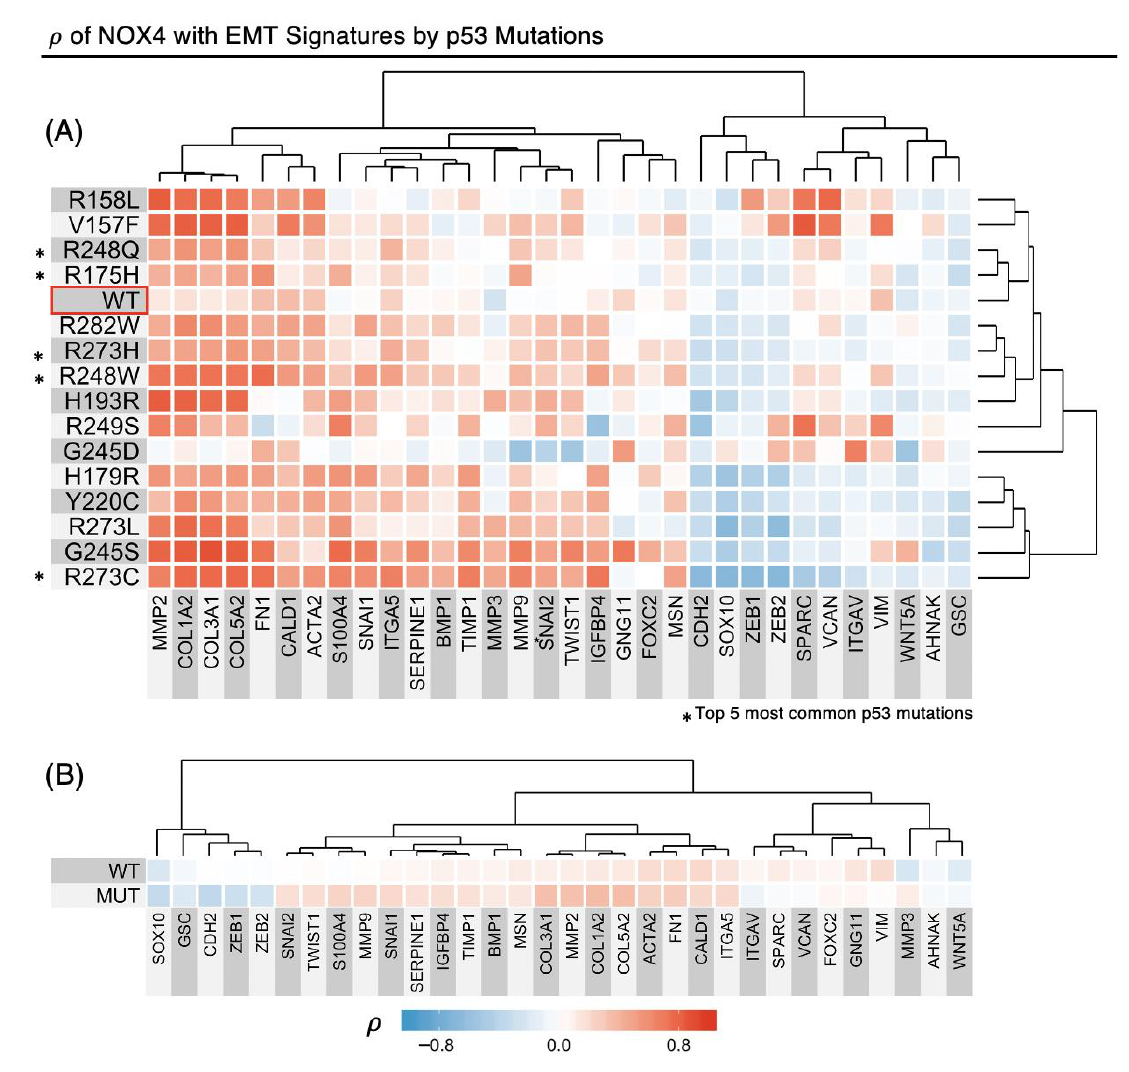
Figure 6. Common TP53 mutations strengthen the correlation coefficients of NOX4 mRNA with EMT genes. ( A ) Samples in the Final Pan-Cancer Dataset were identified as harboring WT- TP53 or any of the indicated common Mut- TP53 , and the Spearman’s rank correlation coefficients ρ were calculated for NOX4 with the EMT genes indicated on the x -axis. ( B ) All p53 mutations studied were collapsed into one group, indicated by mutant (MUT), versus wild-type (WT), and the resulting ρ of NOX4 -EMT genes were mapped. Unsupervised clustering was performed for both ( A ) and ( B ).